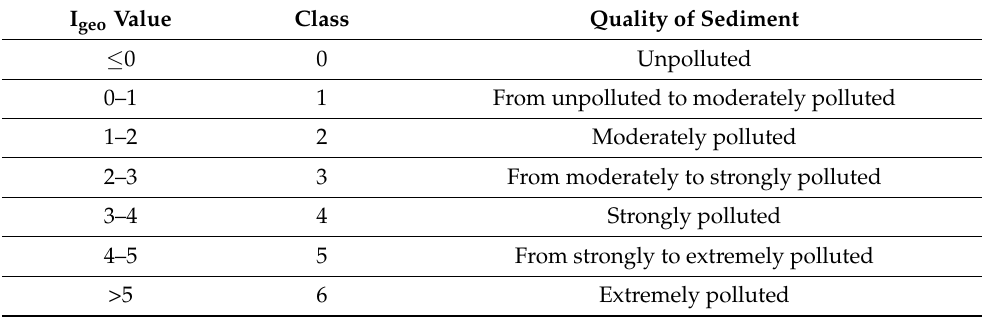
Table 5. I geo by Muller’s classification for geochemical index